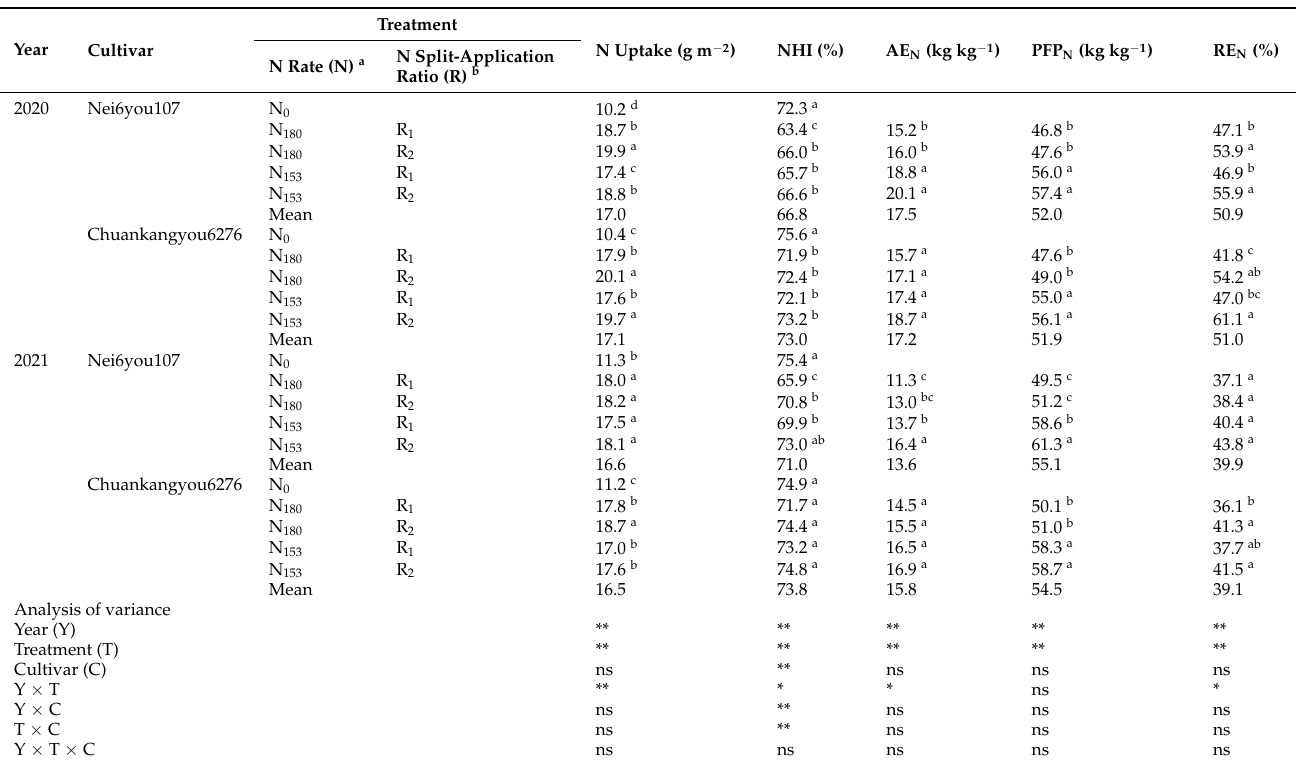
Table 5. Effect of different N management practices on nitrogen uptake (NU), nitrogen harvest index (NHI), agronomic efficiency of applied N (AE N ), partial factor productivity of applied N (PFP N ), and recovery efficiency of applied N (RE N ) of hybrid rice in the no-tillage, direct-seeded (NTDS) cropping